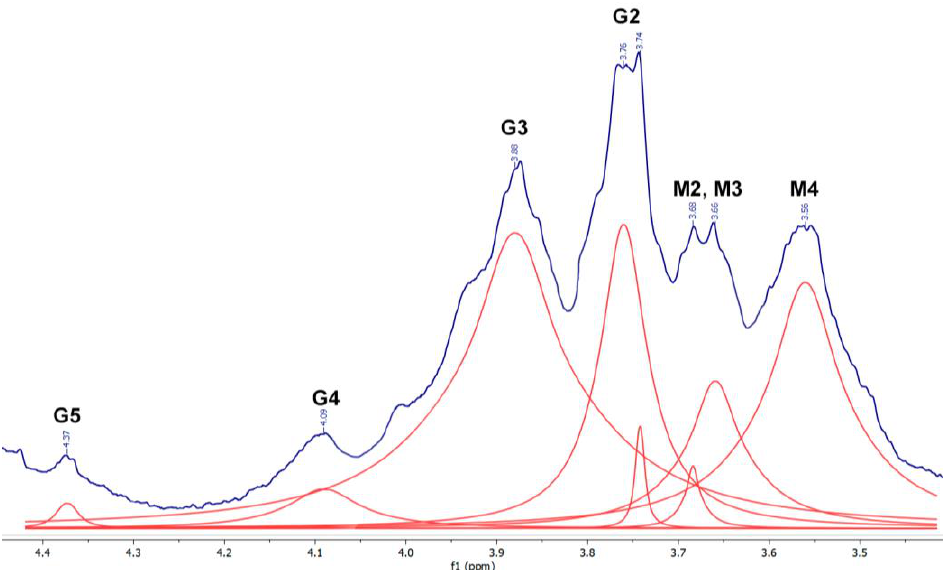
Figure 2. 1 H NMR spectrum of ALG. Fitting is represented by red lines, fitting baseline is shown at the bottom.